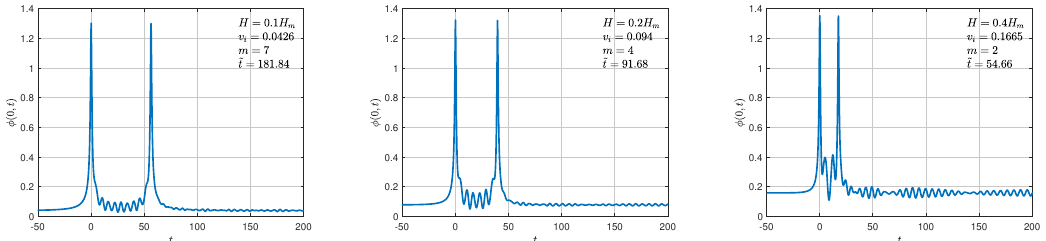
Figure 14 . Φ 2+ ( x ) antikink scattering with φ 1 boundary: scalar field at the boundary φ (0 , t ) as a function of t for collisions from the first visible two-bounce window. a) H = 0 . 1 H m , b) H = 0 . 2 H m , c) H = 0 . 4 H m . The number m of oscillations between bounces for the first visible two-bounce windows is also indicated. In each figure the time t was rescaled as t to the first peak.